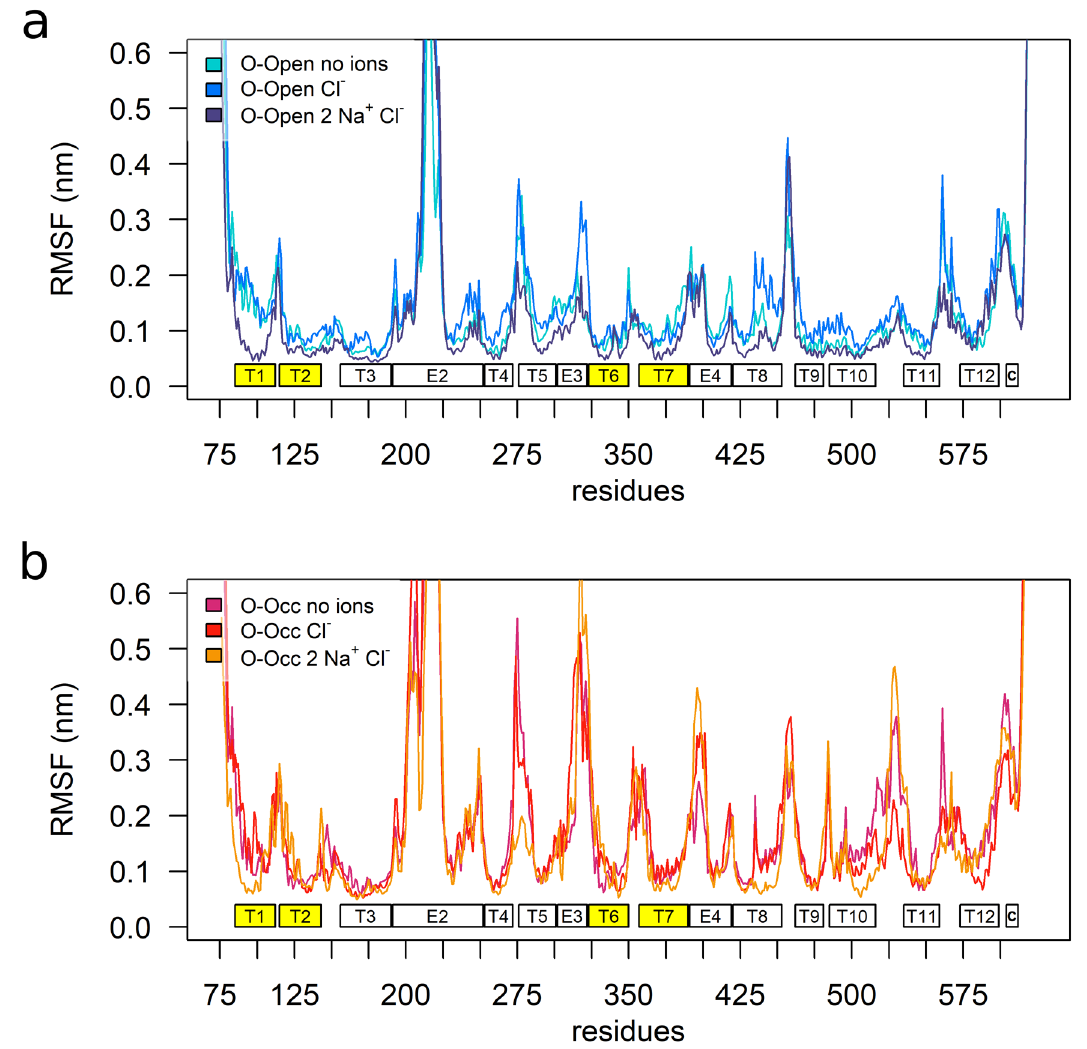
Figure 1. The dynamics of the human serotonin transporter (hSERT). Simulations starting from the O-Occ cryo-EM structure showed higher fluctuations as compared to the simulations starting from the O-Open structure. Root-mean-square fluctuation (RMSF) plots showed the mobility of C α atoms of ( a ) the O-Open and ( b ) O-Occ conformations and their dependences on the bound ions, averaged over five independent parallel runs with a 1 ns temporal resolution.